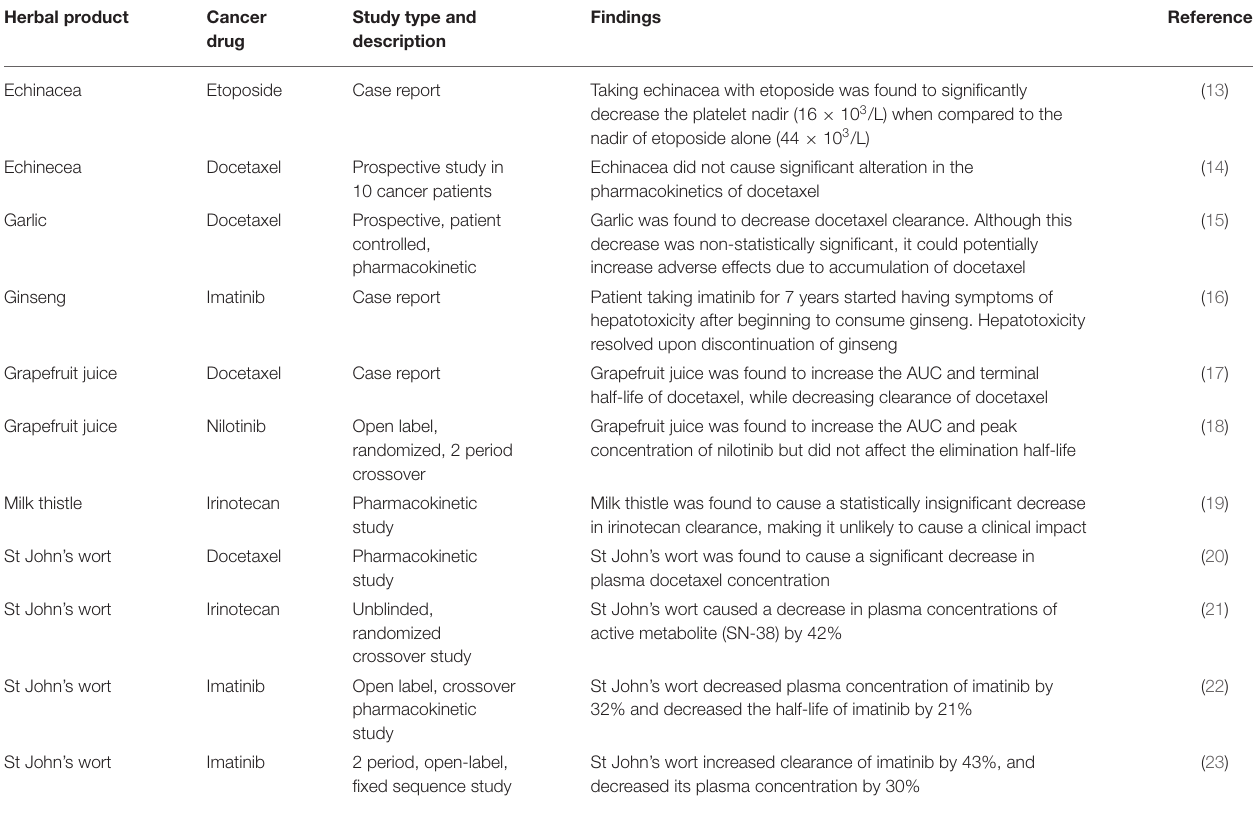
TABLE 1 | Studies of herbal interaction with chemotherapeutic agents conducted in human subjects. Herbal product Cancer